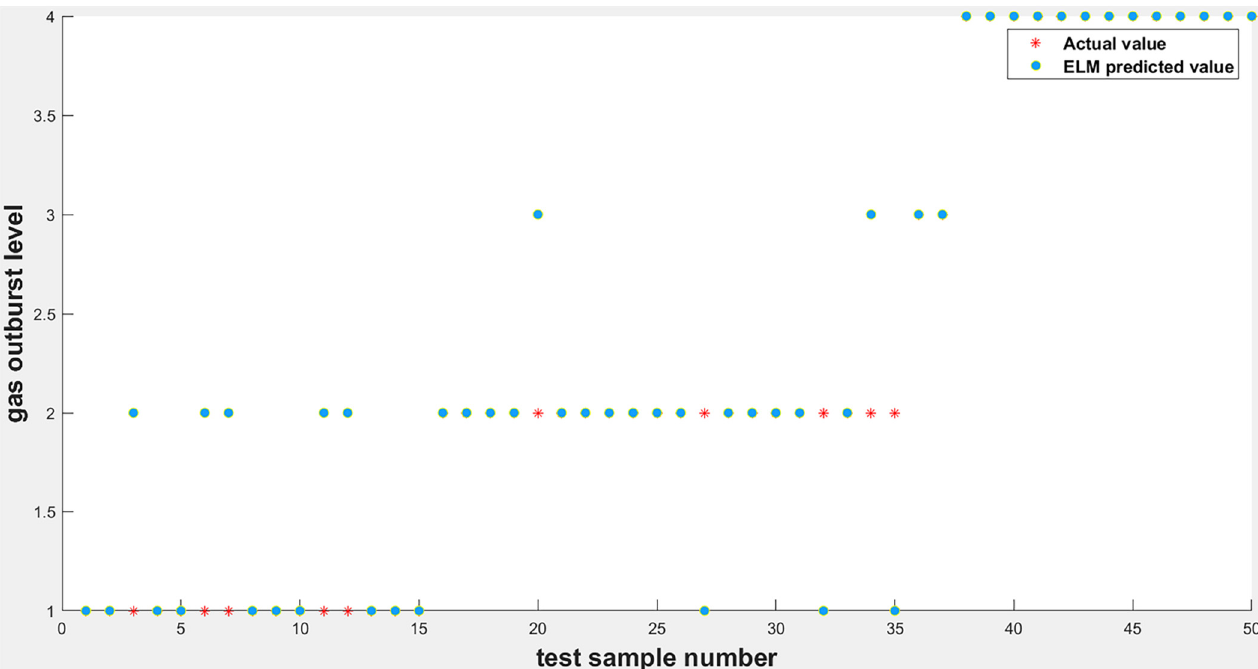
Figure 4. ELM model simulation output results.